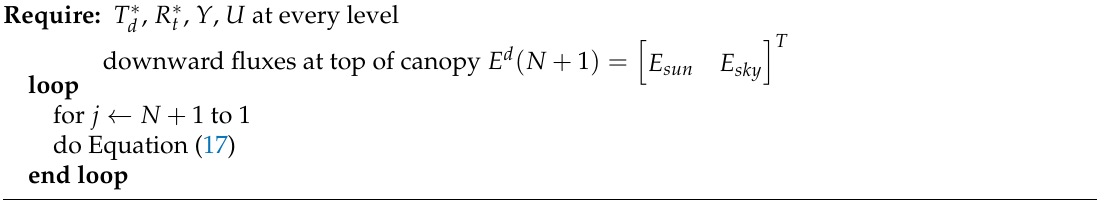
Algorithm 2 Calculate E d , E u